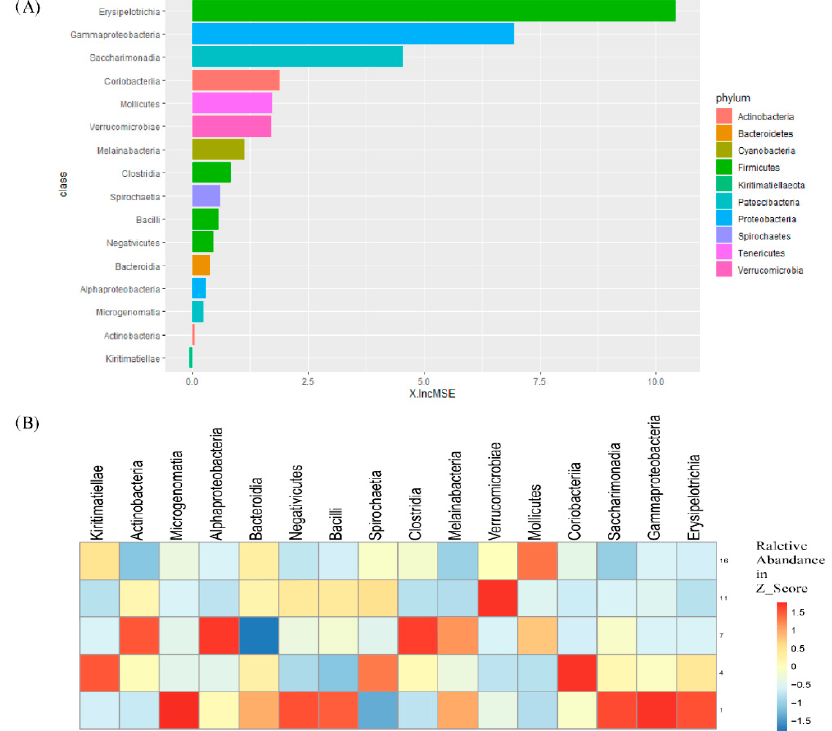
Figure 6. The key bacteria of feedlot feeding periods (D1, D4, D7, D11, D16) in yaks. ( A ) The key bacteria in class were identified by applying random forest regression. ( B ) Heatmap showing the changes in relative abundances of bacteria ordered by importance in feedlot feeding period.